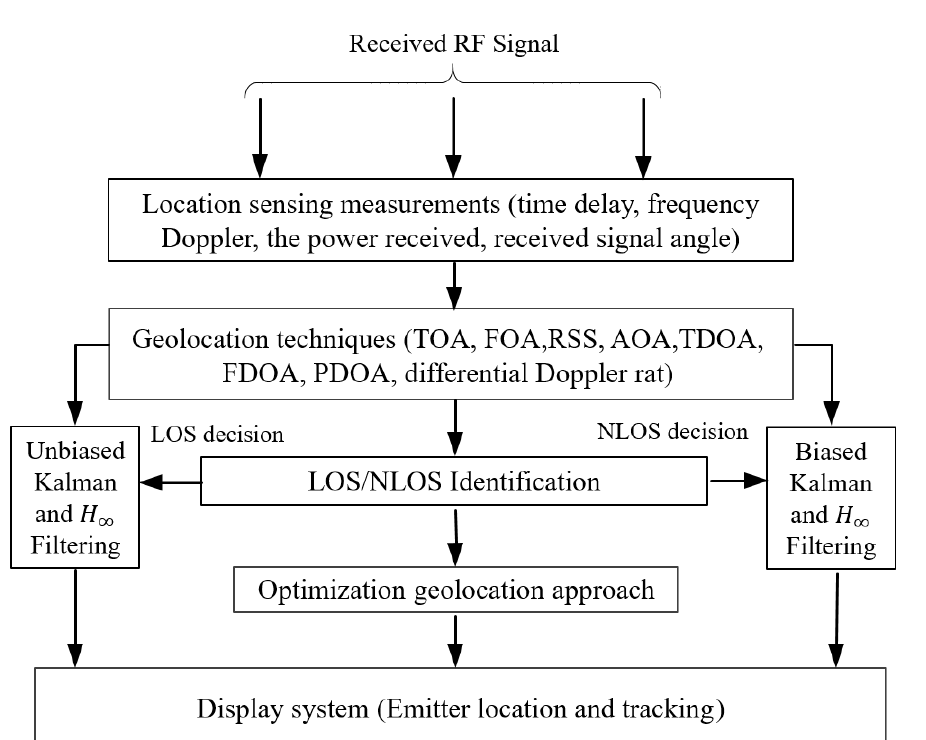
Figure 2. Flow of geolocation and target tracking system.